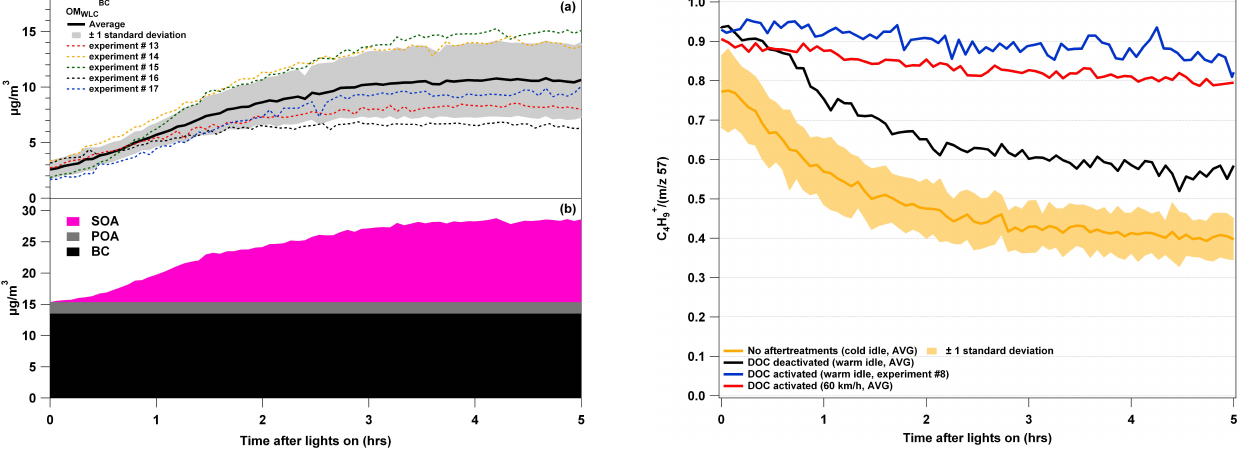
Fig. 4. Temporal evolution of the fraction of C 4 H + Fig. 3. (a) Temporal evolution of the wall-loss corrected organic The orange and blue lines are average ) for the diesel vehicle with- aerosol mass concentration (OM BC WLC out aftertreatments and, (b) temporal evolution of OM BC for the WLC same experiment in Fig. 2a, b: total organics is the sum of the pink and gray areas with the gray area equal to POA, assuming a con- stant POA to BC ratio for the full experiment. The pink area is the estimated SOA from subtracting the POA from the total OA.